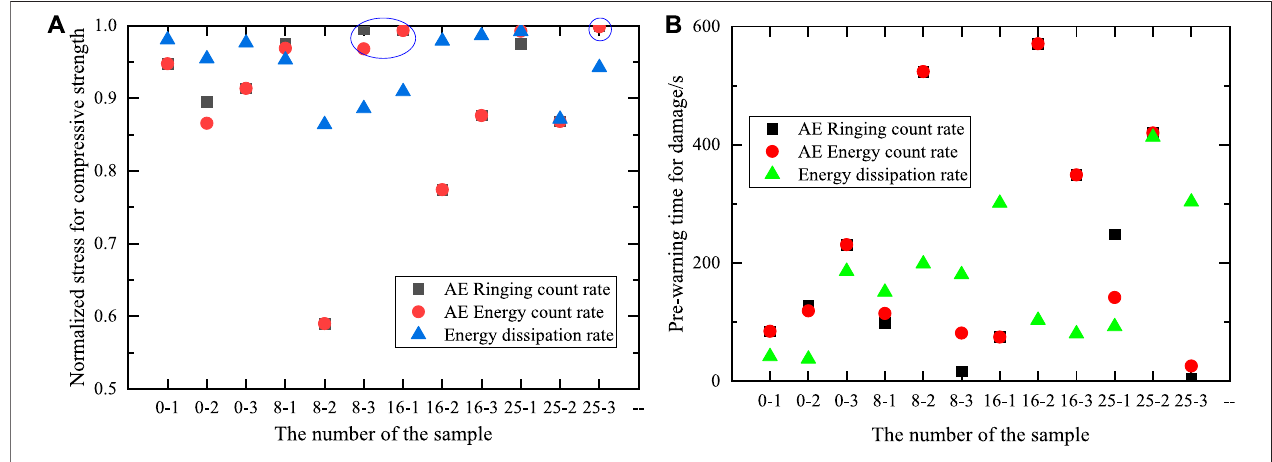
FIGURE 11 | Comparison of failure precursor features. (A) Normalized stress of compressive strength, (B) Pre-warning time of damage.